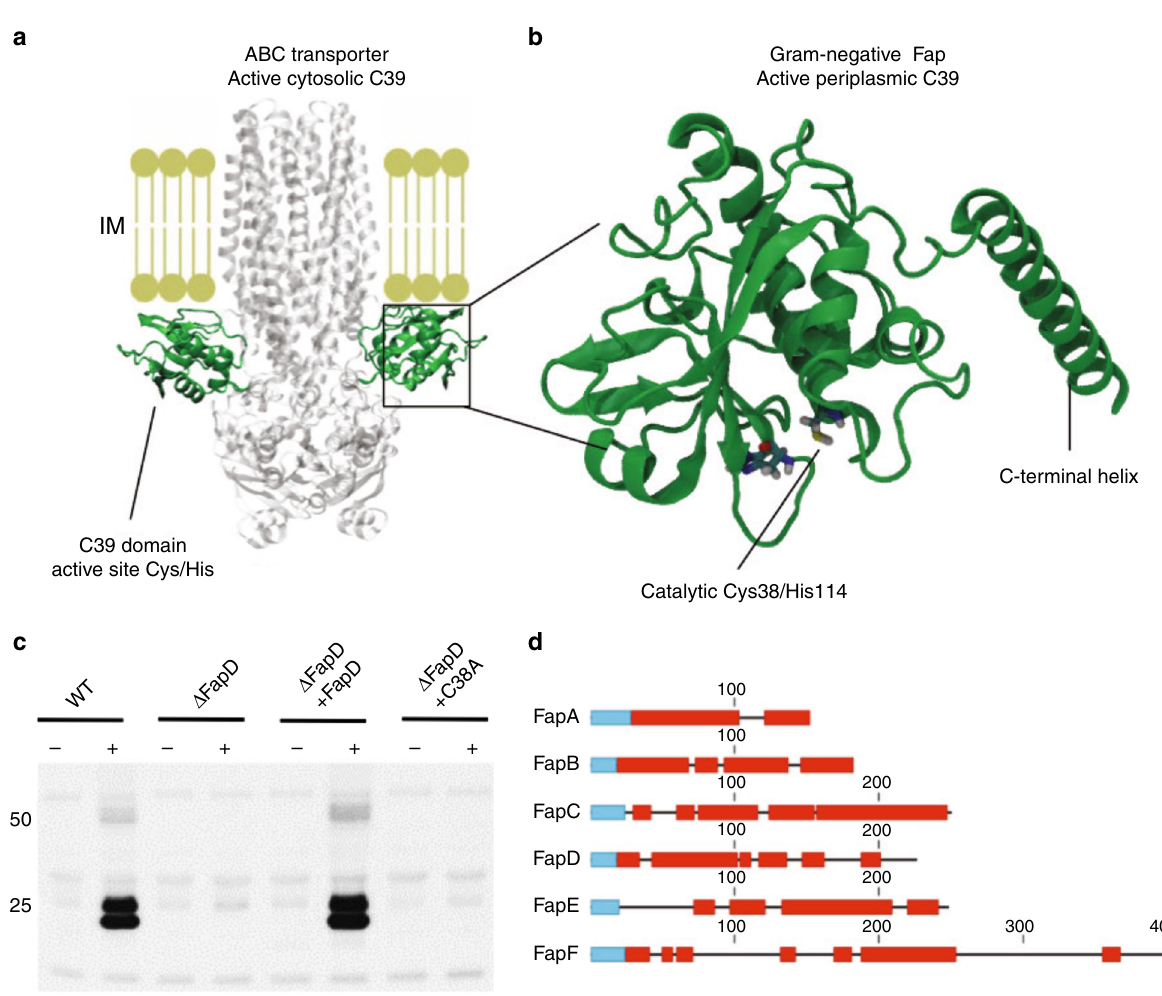
Fig. 5 FapD is a periplasmic C39 protease required for FapC secretion. a Comparison of C39 domains in peptidase-containing ATP-binding cassette transporters. b FapD homology model generated by i-Tasser from PDB id 4ry2 ( green ). The active site His and Cys are conserved and shown in stick representation . c A C38A mutant was unable to secrete FapC fi bres demonstrating FapD functions as an active peptidase. Coexpression of the FapD knockout operon with a plasmid encoding wild-type FapD with an OmpA signal sequence restores FapC secretion and con fi rms FapD is active in the periplasm. The 25 and 50 kDA MW markers are shown. d Mapping of peptides observed in whole-cell lysates of Pseudomonas sp. UK4 expressing the complete fap operon to the Fap protein sequences. Regions with matching peptides are shown as red boxes and the signal peptides, which are absent in the mature proteins, are shown as blue boxes . For additional details, see the Supplementary Data 2. Peptides are observed for FapA – D throughout the sequence indicating no processing. No peptides were observed in the mature N-terminal of FapE, although sequence analysis indicate the possibility for several theoretical peptides of proper size. This indicates a proteolytical processing of FapE. For FapF the disordered linker region residue 60 – 100 is potentially processed whilst the putative coiled-coil region remains molecular dynamics simulations of FapF β were performed to ‘ pull ’ the helix plug from the pore (Supplementary Fig. 14). These indicated that the F102 is a key anchoring point for the helix plug domain within the barrel lumen. Furthermore, unbiased